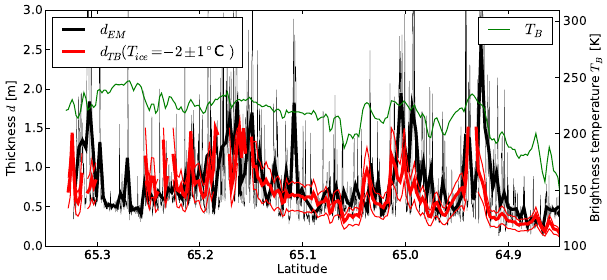
Fig. 6. Thickness retrievals and brightness temperature from the flight of 13 March 2007. The graph shows the EM-thickness d EM and the thickness d TB derived from the brightness temperature for the prescribed ice temperature T ice =− 2 ± 1 ◦ C. The thin black line represents the EM-thickness at 40m resolution while the thick line is a running average over about 1200m. The red lines indicate the L-band thickness retrieval including the sensitivity rage for a ± 1 ◦ C temperature changes. Data gaps in the red ( d TB ) curve indicate failures of the retrieval